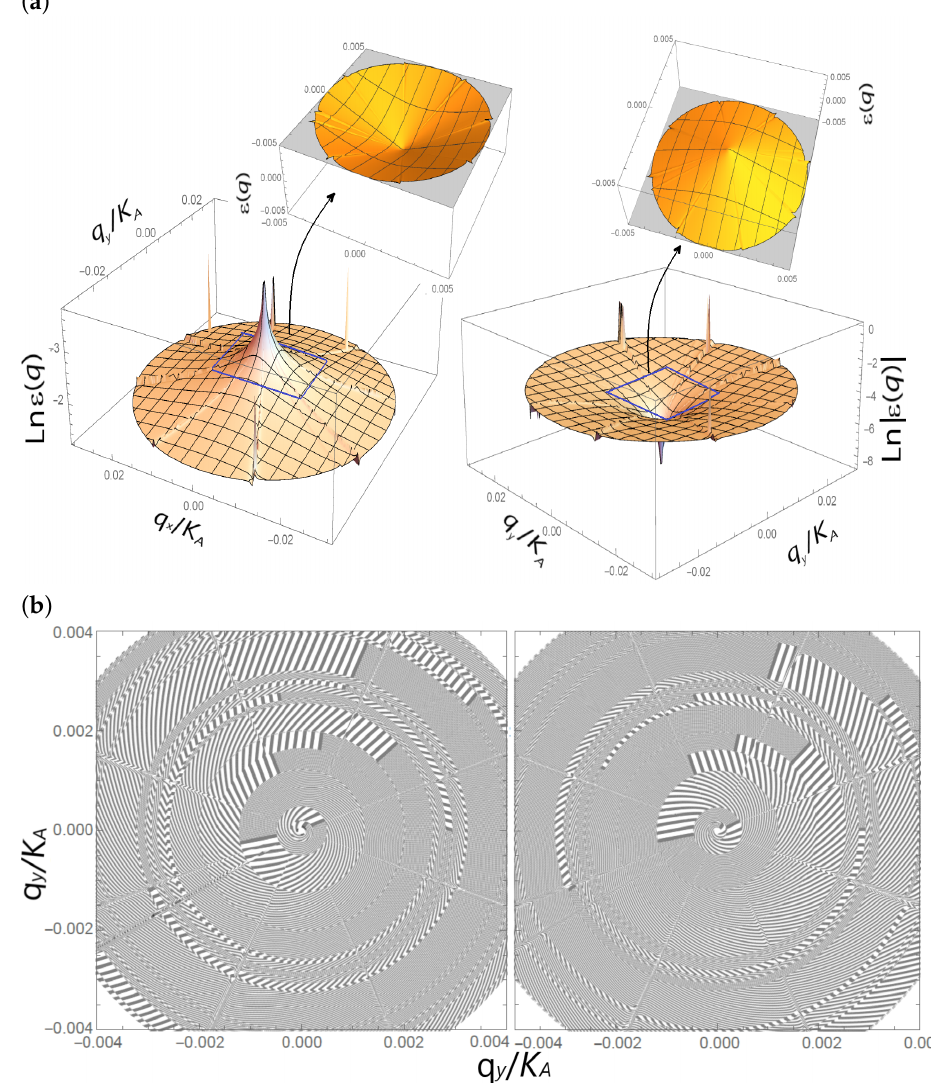
Figure 2. ( a ) Electron ( left ) and hole bands ( right ) of a quasi-relativistic N F = 3-flavors model graphene with a pseudo-Majorana mass term. ( b ) The vortex texture in contour plots of the graphene electron ( left ) and hole ( right )